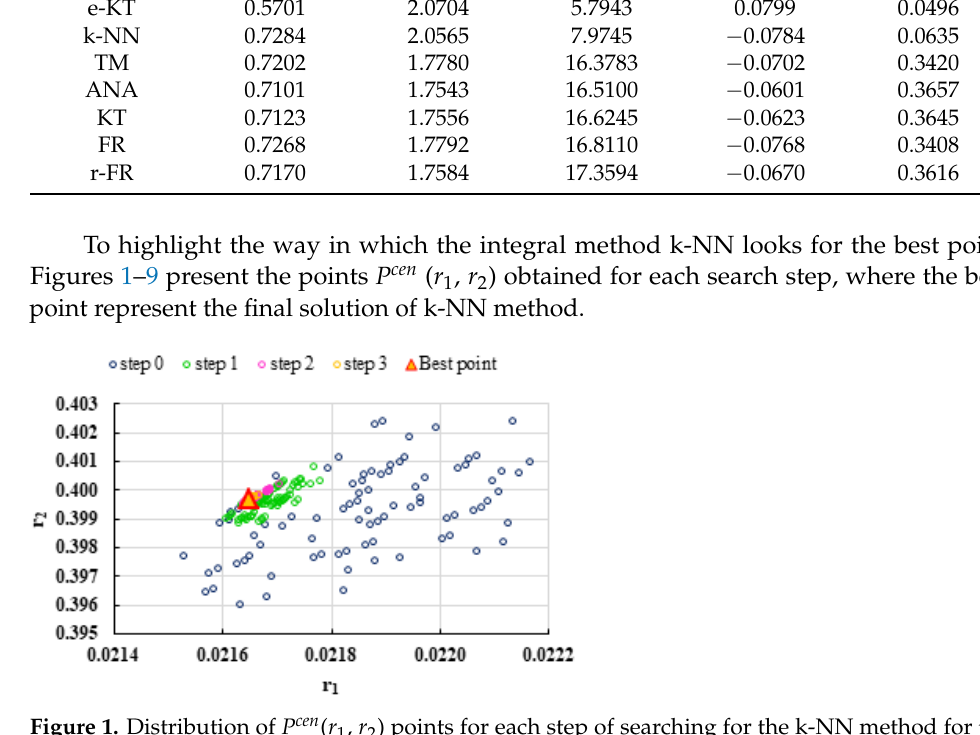
Figure 1. Distribution of P cen ( r 1 , r 2 ) points for each step of searching for the k-NN method for the conditions imposed by LC1.